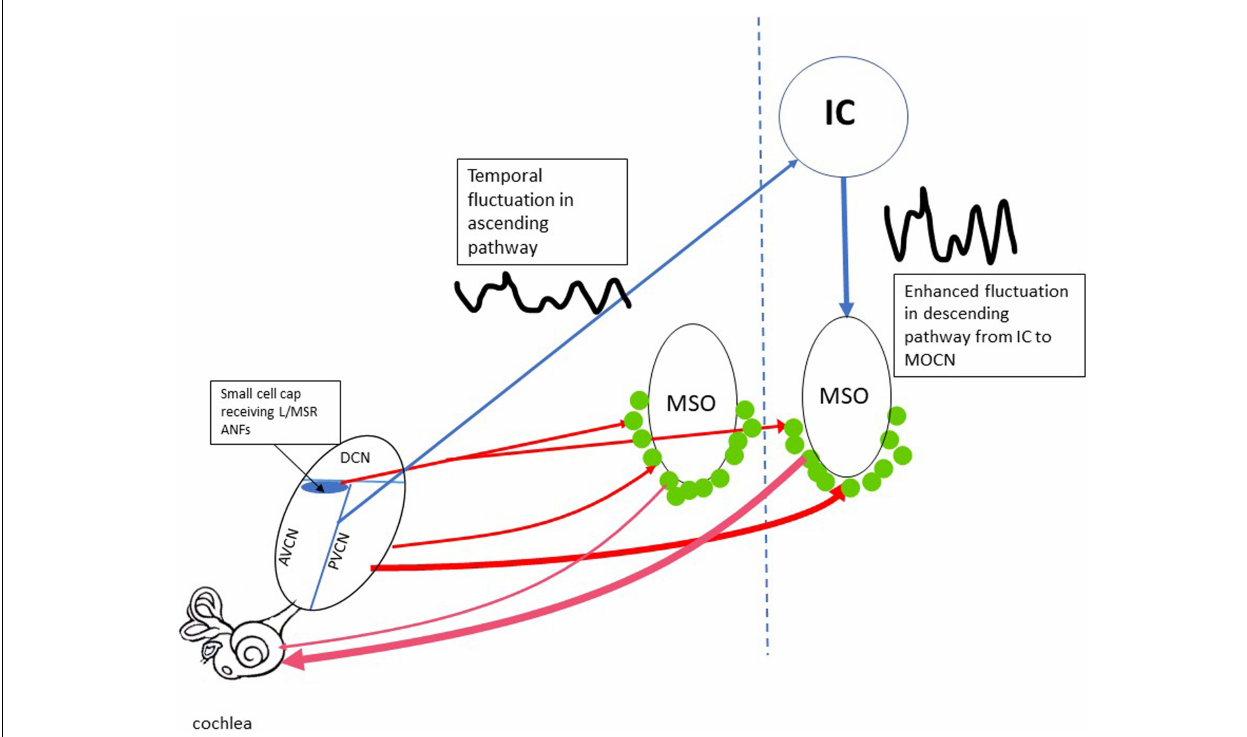
FIGURE 2 | The efferent feedback loops controlling the OHC gain. The short loops going through lower brainstem are marked by redlines. The thickness of the line represents the relative strength in the typical loop from PVCN to MOCNs (green dots). The loop from the small cell cap in AVCN to MOCN is thought to be selective receiving input from L/MSR ANFs. The relative strength of this loop is unknown. The long feedback loop (blue lines) includes the projection from both AVCN and PVCN cores to IC, which is sensitive to the low-frequency temporal fluctuation. The fluctuation is inherited and enhanced in the descending projection from IC to MOCNs. AVCN/PVCN, anterior/posterior ventral cochlear nucleus; DCN, dorsal cochlear nucleus; MOCN, medium olive cochlea neurons; MSO, medium superior olive; IC, inferior